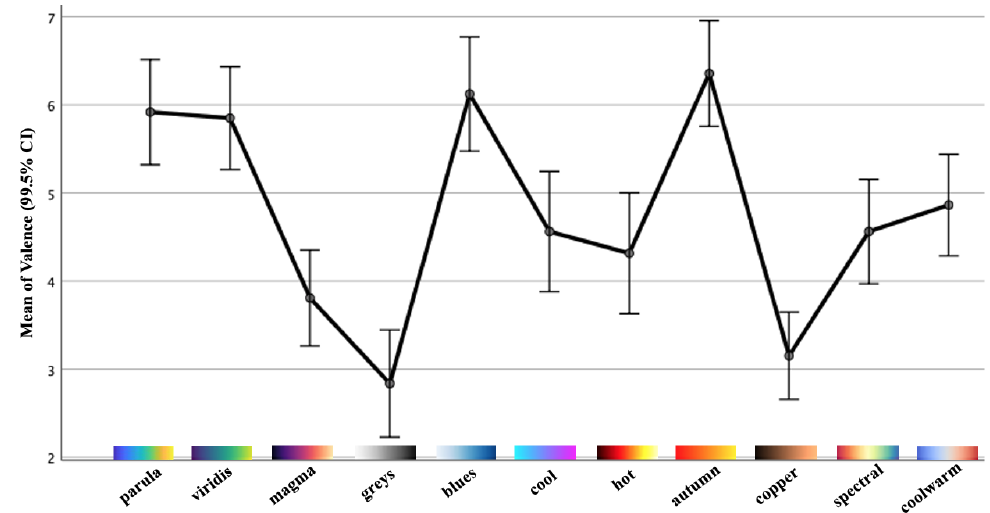
Figure 11. Mean values with standard errors (99.5% CI) of the valence dimension.